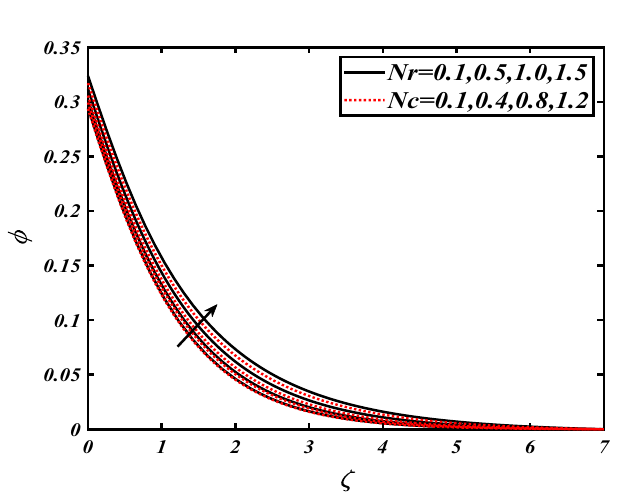
Figure 10. Illustration of Nr and Nc over nanoparticles concentration φ when Rd = 0.4, γ 2 = 0.3, γ 1 = 0.3, Nt = 0.3, Nb = 0.2, S = 0.5, (cid:31) = 0.5 .